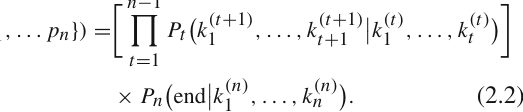
Fig. 1 Junipr predicts the probability density P jet ( { p 1 ,..., p n } ) of finding a given set of momenta { p 1 ,..., p n } in a jet, conditioned on the jet selection criteria used to select the training data. No assumptions are made about the underlying quantum-mechanical processes that gener- ated the jet